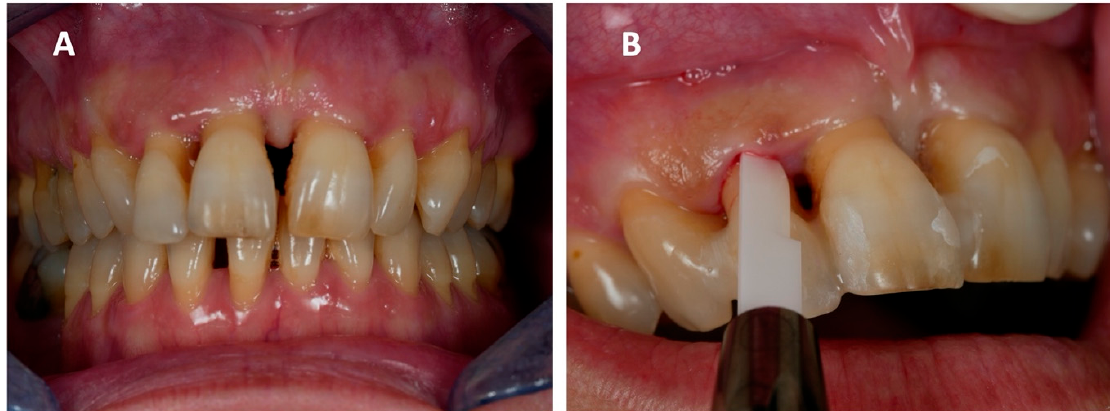
Figure 1. The disease’s initial status at the first visit: ( A ) Diffused and significant periodontitis can be seen, mainly affecting the superior incisors, and ( B ) deep periodontal pockets with active inflammation and bleeding.